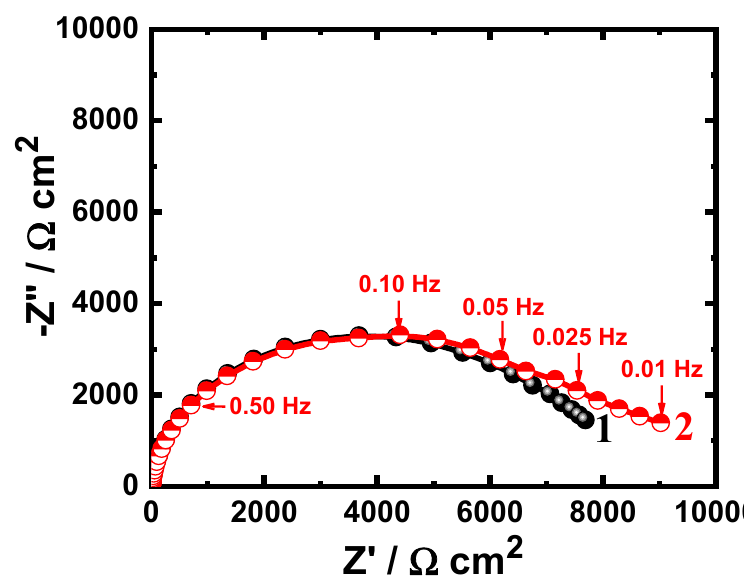
Figure 6. Nyquist plots of ( 1 ) uncoated API-2H steel and ( 2 ) 75%Cr 3 C 2 − 25%NiCr coated API-2H steel after 48 h immersion in 4% NaCl solutions.